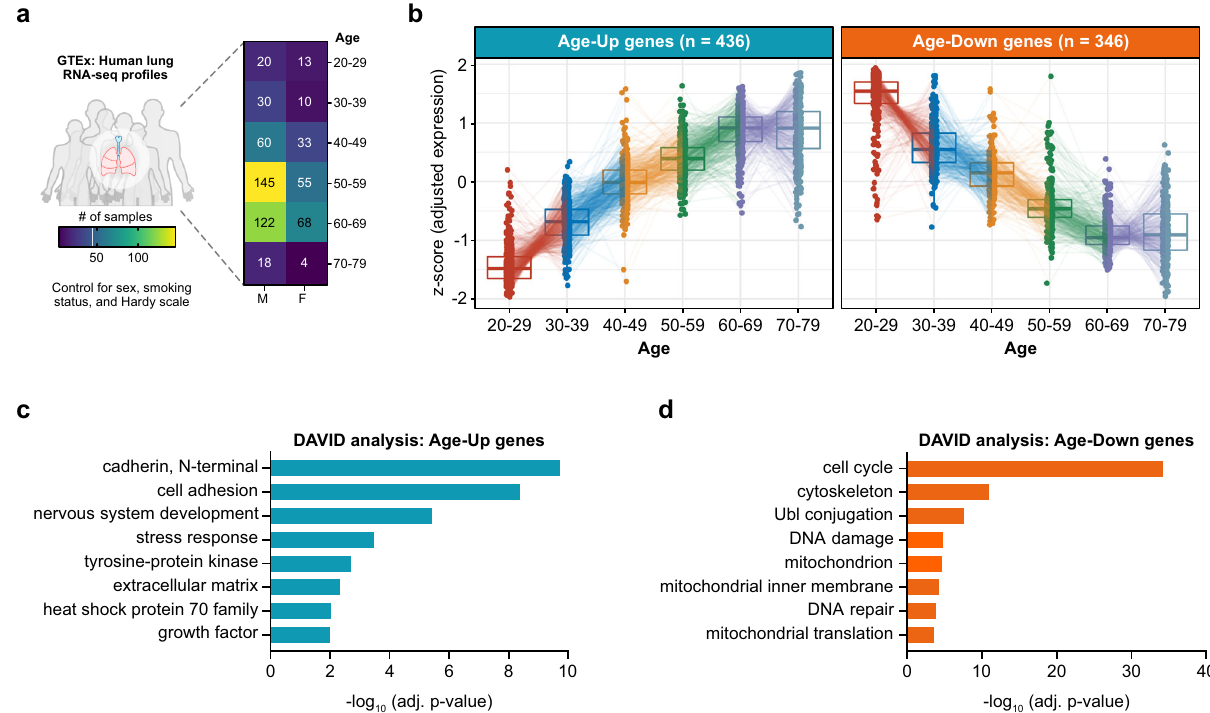
Fig. 1 Identi fi cation of age-associated genes in the human lung. a Demographics of the human lung RNA-seq pro fi les in the GTEx dataset, detailed by sex and age group ( n = 578 samples). Downstream analyses were controlled for sex, smoking status, and Hardy scale, retaining samples with complete clinical annotations ( n = 561). b Tukey boxplots (interquartile range (IQR) boxes with 1.5× IQR whiskers) of age-associated genes in the human lung. Age-Up genes increase in expression with aging (left, n = 436), while Age-Down genes decrease in expression with aging (right, n = 346). Statistical signi fi cance was assessed by DESeq2 two-sided likelihood-ratio test (adj. p < 0.05) controlling for sex, smoking status, and Hardy scale. Data are shown in terms of median z -score of gene expression, after adjustment for sex, smoking status, and Hardy scale. c DAVID gene ontology and pathway analysis of Age-Up genes. d DAVID gene ontology and pathway analysis of Age-Down